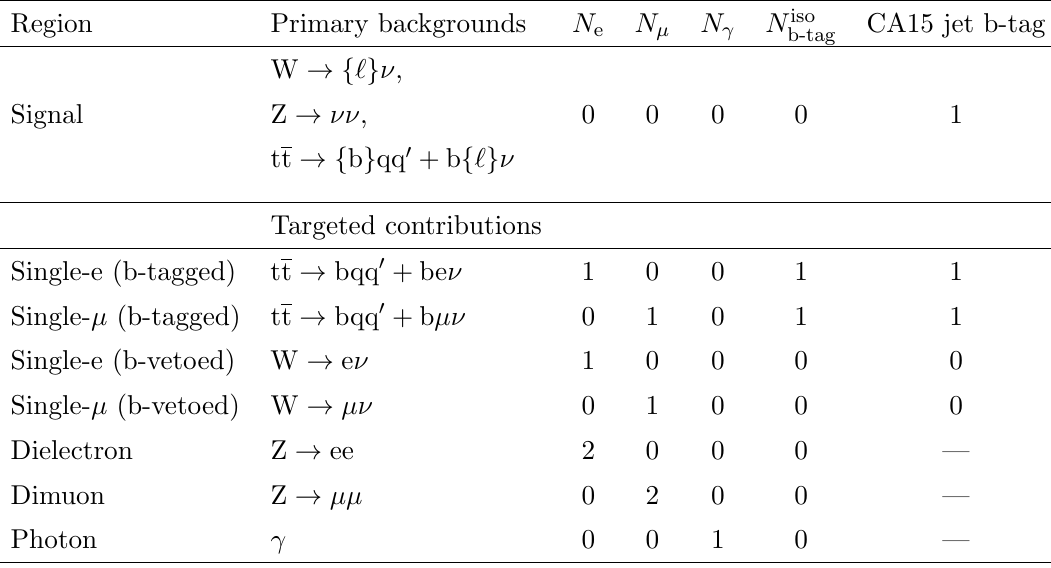
Table 1 . Summary of the selection criteria used in the SR and CRs. Symbols to cases where the b quark or lepton are not identi(cid:12)ed. The symbols N e , N (cid:22) , and N (cid:13) refer to the number of selected electrons, muons, and photons, respectively. The number of b-tagged isolated jets is denoted with N iso b-tag